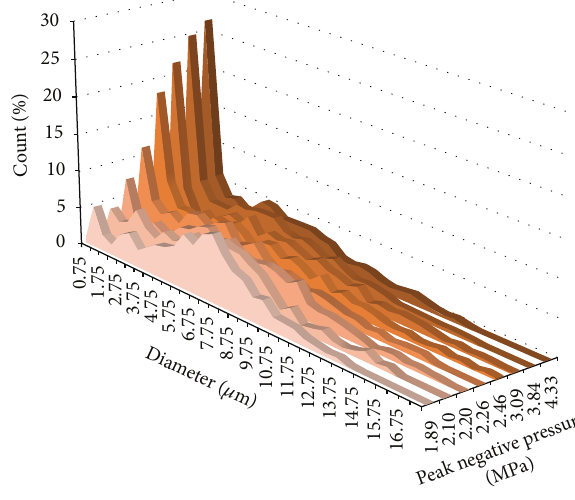
Figure 7: Histogram of all bubble sizings taken at 5.5 MHz ( 𝑁 = 11 ,654)asafunctionofrarefactionalpressure.Aspressureincreases, the number of small bubbles increases in proportion until the smallest bin size overtakes as the peak in the distribution. Con- tinued increase in the pressures amplifies the proportion of these small bubbles relative to other bubbles present in the distribution. Reproduced from [91] with permission from the Institute of Physics in Engineering and